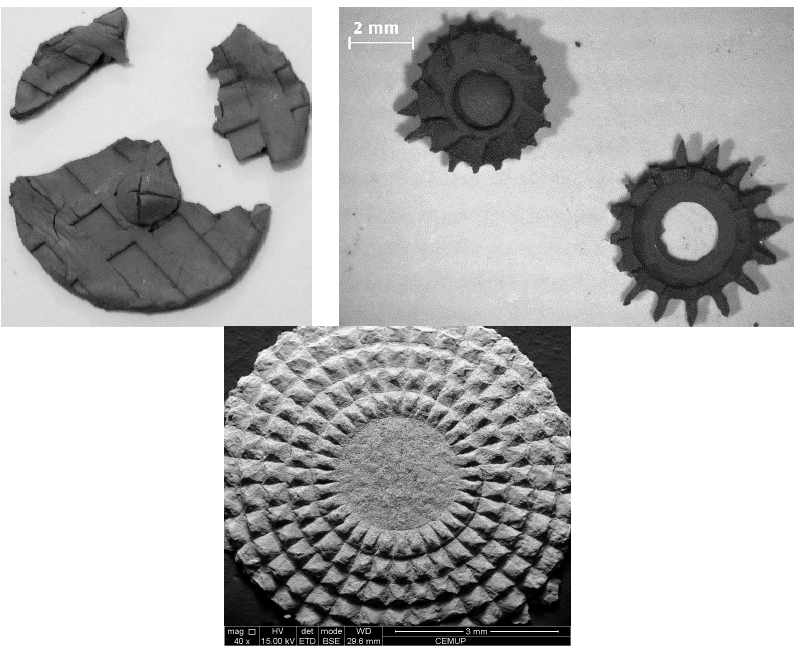
Figure 4. Images of broken or damaged green parts after the embossing step.